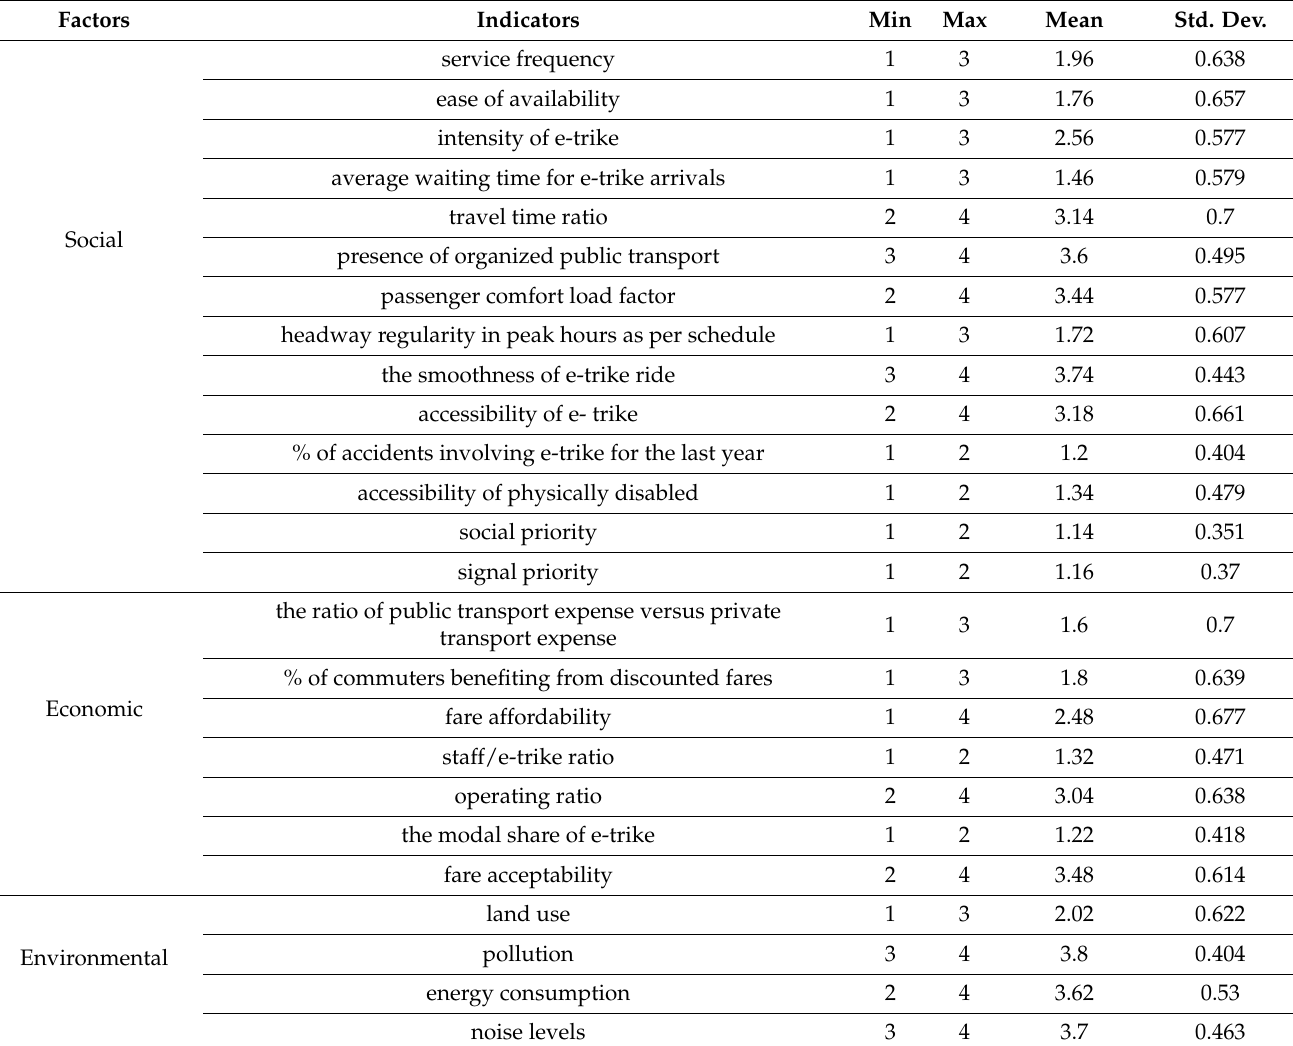
Table 8. Summary data for indicators for public transport